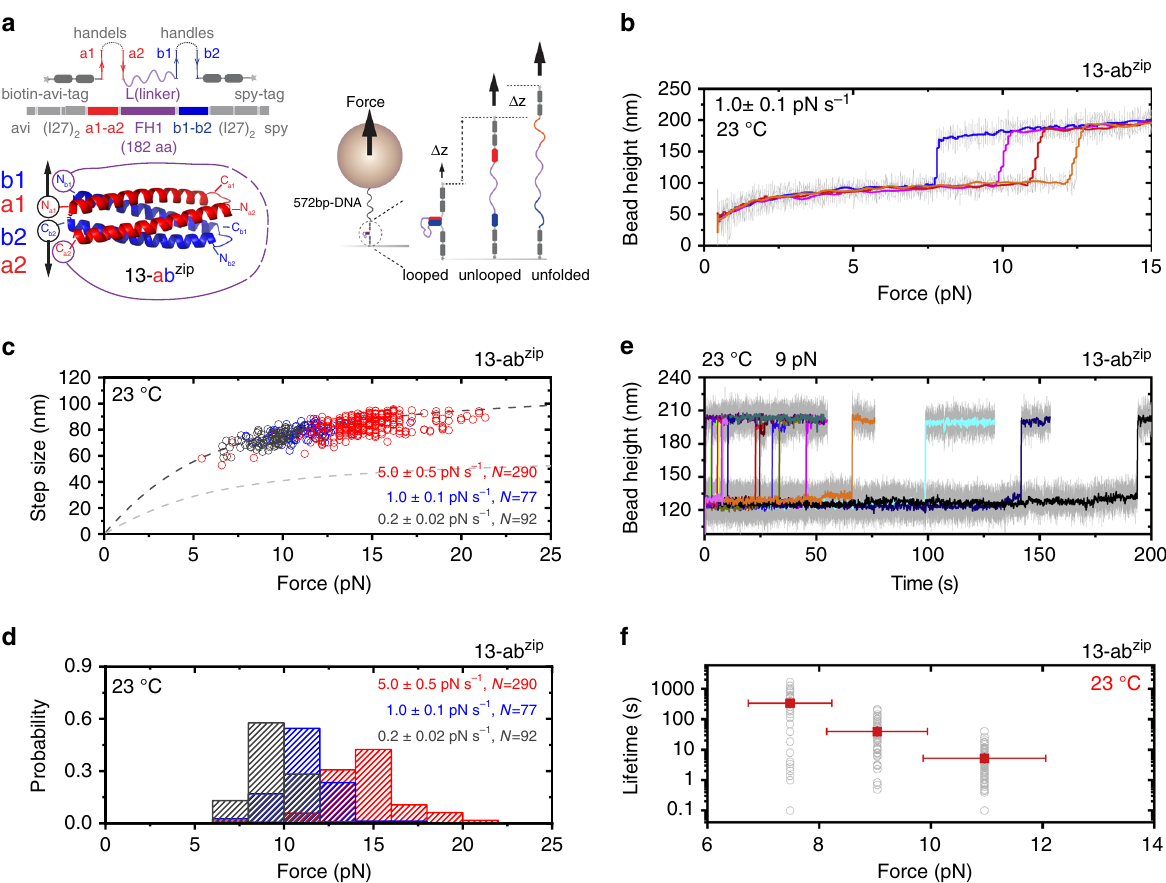
Fig. 1 Single-molecule quanti fi cation of the mechanical stability of 13-ab zip . a Left-top panel: design of the 13-a1a2Lb1b2-construct. Left-bottom panel: the expected structure of 13-ab zip . Black circles and black arrows indicate the force-attaching points and force direction. Purple circles indicate the attachment points of the long linker. Components a and b are helix-hairpins that contains two helices a1&a2 (red), and b1&b2 (blue), respectively. Right panel: sketch of a single-molecule construct speci fi cally tethered between a coverslip surface and a superparamagnetic bead with a 572-bp DNA handle (Supplementary Note 2). b Four representative force – height curves of the single-molecule 13-a1a2Lb1b2-construct at 1.0 ± 0.1 pN s − 1 . The stepwise bead height jump indicates the force-induced rupturing (unlooping) of the 13-ab zip . c The force – step size graph of the force-dependent rupturing (unlooping) transitions of the 13-ab zip . The dash curves are the theoretically predicted. The dark gray line is predicted assuming that in the unlooped state a and b components are unfolded into an unstructured peptide chain; the light gray line is predicted assuming that the a and b components remain as folded helix-hairpin structures (Supplementary Note 6 and Supplementary Figs. 4 and 5). d Normalized histograms of the 13-ab zip rupture forces. e Representative time traces of the bead height before and after the rupture of the 13-ab zip at ~9 pN, where the rupturing events are indicated by the large bead height jump steps. f Force- dependent lifetimes of the 13-ab zip . The solid squares represent the average lifetimes ( τ ) obtained by best- fi tting of the lifetime histogram to a single- exponential decay function. The hollow gray circles represent individual lifetimes ( N ~ 100 for each force). The vertical error bars indicate the standard p . The horizontal error bars indicate 10% of relative force uncertainty resulted from the force-calibration method. For errors of the lifetime obtained by τ ffiffiffiffiffiffiffi N (cid:1) 1 panels b – f : the experiments were performed at 23 °C. For panels b and e : 20-points FFT smooth (colored lines) of the raw data (gray lines) are shown. For panels c , d : the number of data points obtained from >5 independent tethers are indicated. Source data are provided as a Source Data fi